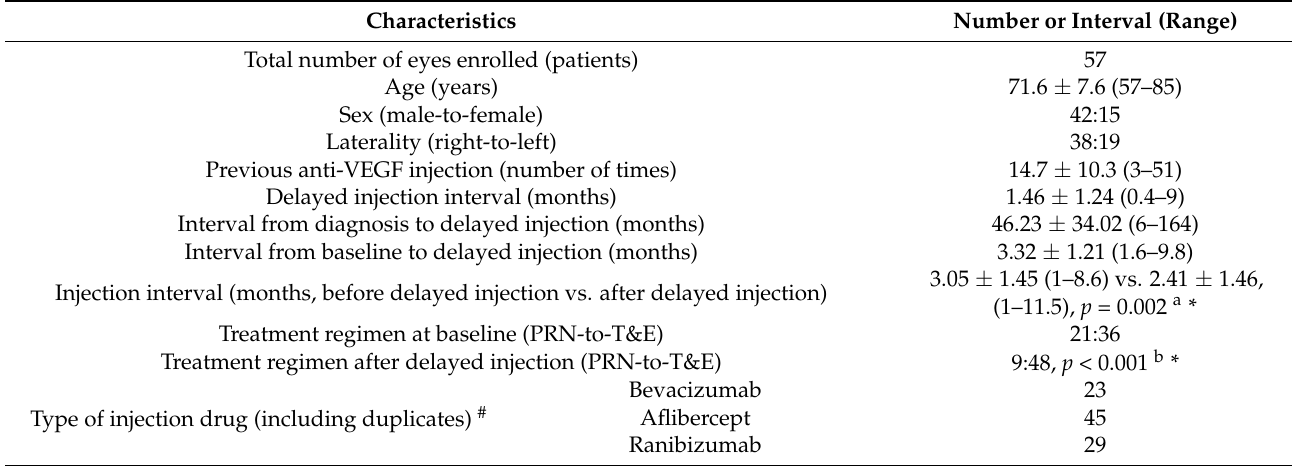
Table 1. Baseline characteristics of